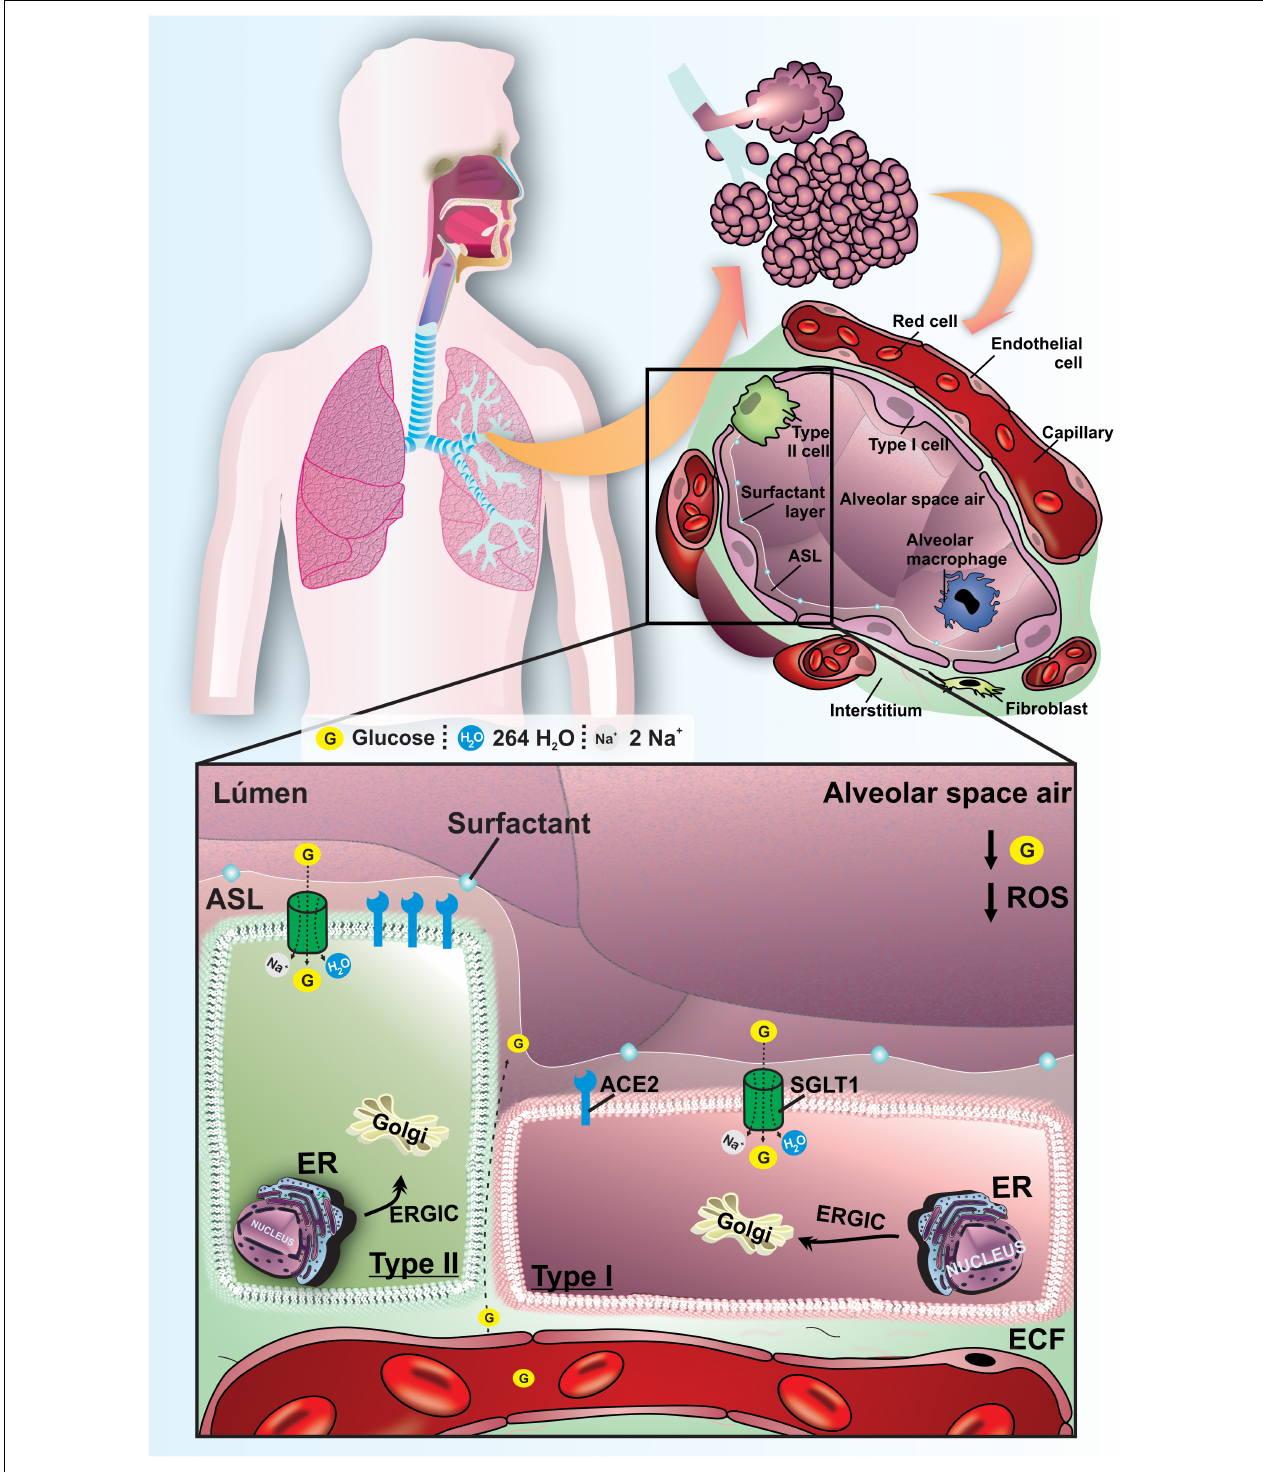
FIGURE 1 | Functional mechanisms to maintain lung homeostasis and to regulated ASL glucose concentration in ASL of healthy normoglycemic subjects. Schematic representation of the lungs of normoglycemic subjects. The low concentration of glucose and the reduced volume in the ASL are mainly maintained by SGLT1 in the apical membrane of type I and II pneumocytes. ACE is present in pneumocytes, with greater expression in type II pneumocytes. The oxidative profile is in balance with low ROS production. G, glucose; SGLT1, Type 1 Na + /glucose/H 2 O cotransporter; ECF, extracellular fluid; ER, endoplasmic reticulum; ERGIC, endoplasmic reticulum-Golgi intermediate compartment; ACE2, angiotensin-converting enzyme 2; ROS, reactive oxygen species. ECL, extracellular liquid.